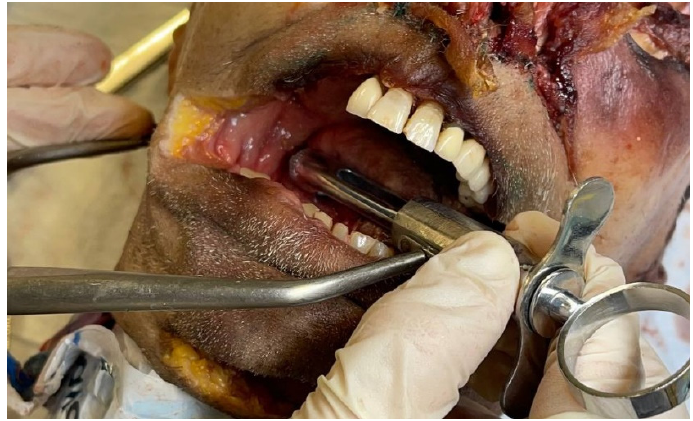
Figure 4. Usage of developing navigation system for IANB performing.